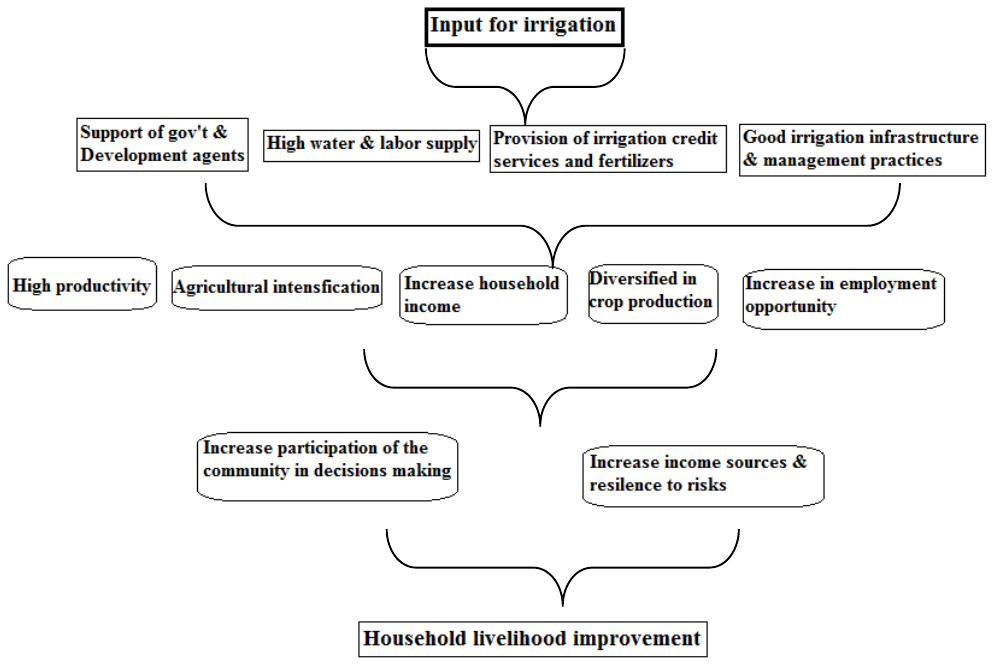
Figure 1. Conceptual framework modified from [23].